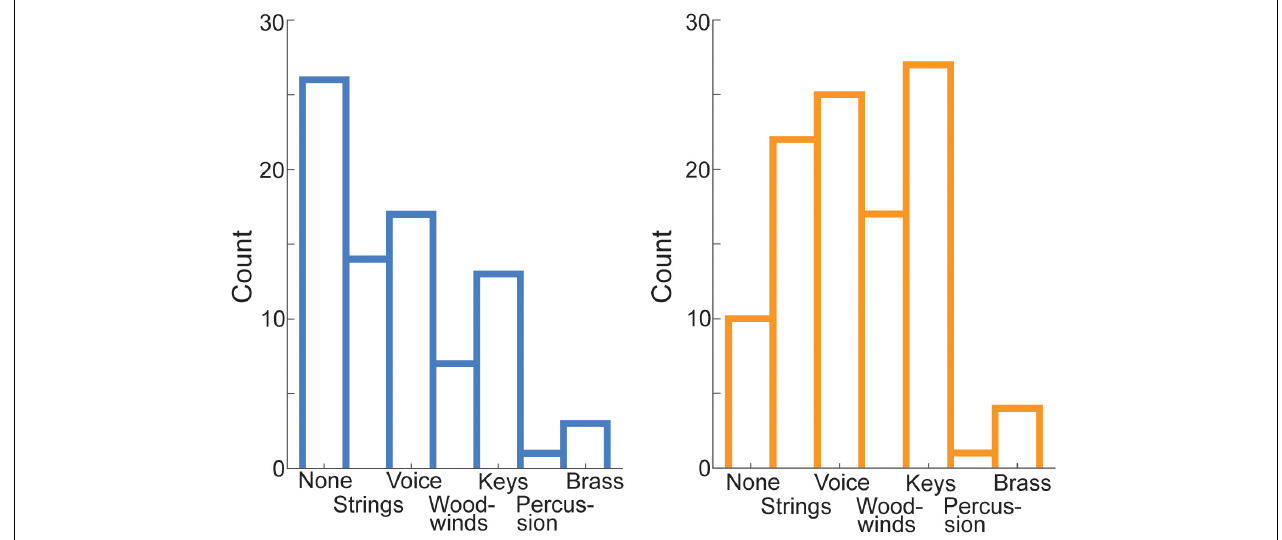
FIGURE 5 | Distribution of the trained instrument across HIGHs and LOWs. HIGHs (displayed in orange) and LOWs (displayed in blue) differed with respect to how many individuals received musical training. However, the distribution of instrument families did not differ, when the category “none” was removed.